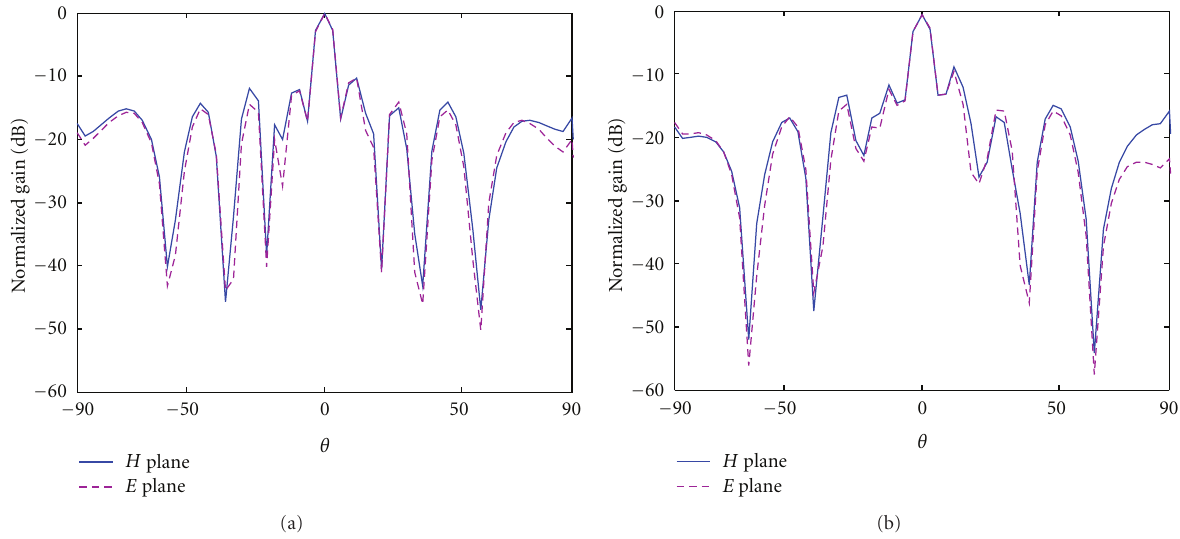
Figure 6: Simulated antenna far-field radiation pattern at 5.5GHz: (a) vertical and (b) horizontal.